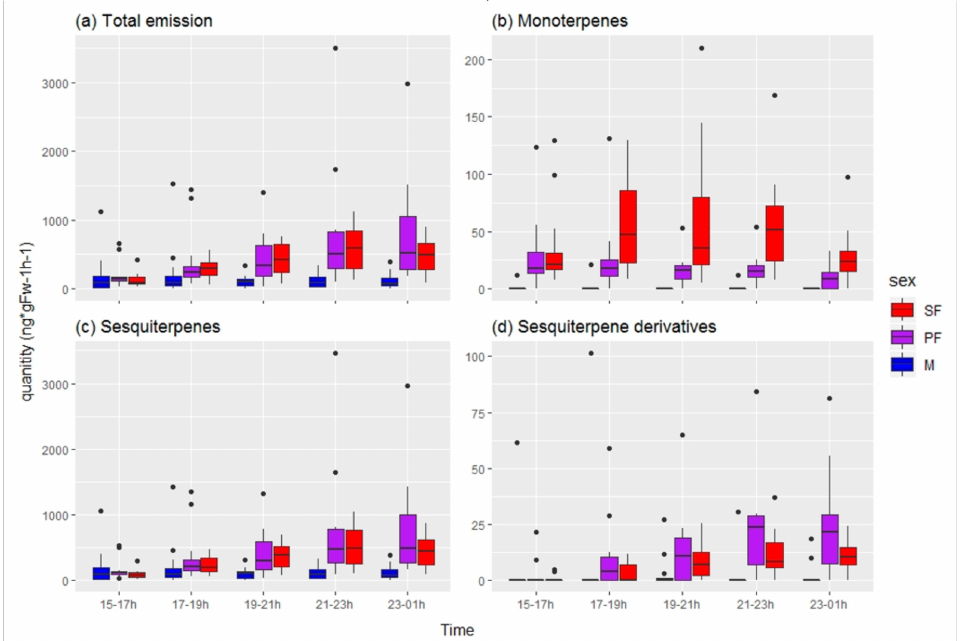
Figure 5. Increase in volatile emission during the night by female Clitarchus hookeri stick insects. SF = sexual females (red), PF = parthenogenetic females (purple), M = males (blue). Emission per individual (ng*gFw − 1 h − 1 ) of ( a ) total quantity, ( b ) monoterpenes, ( c ) sesquiterpenes, and ( d ) sesquiterpene derivatives in two hour intervals. The ends of each box represent the upper and lower quartiles, the median is marked by the vertical line inside the box. The whiskers show the highest and lowest observations, and the black points indicate